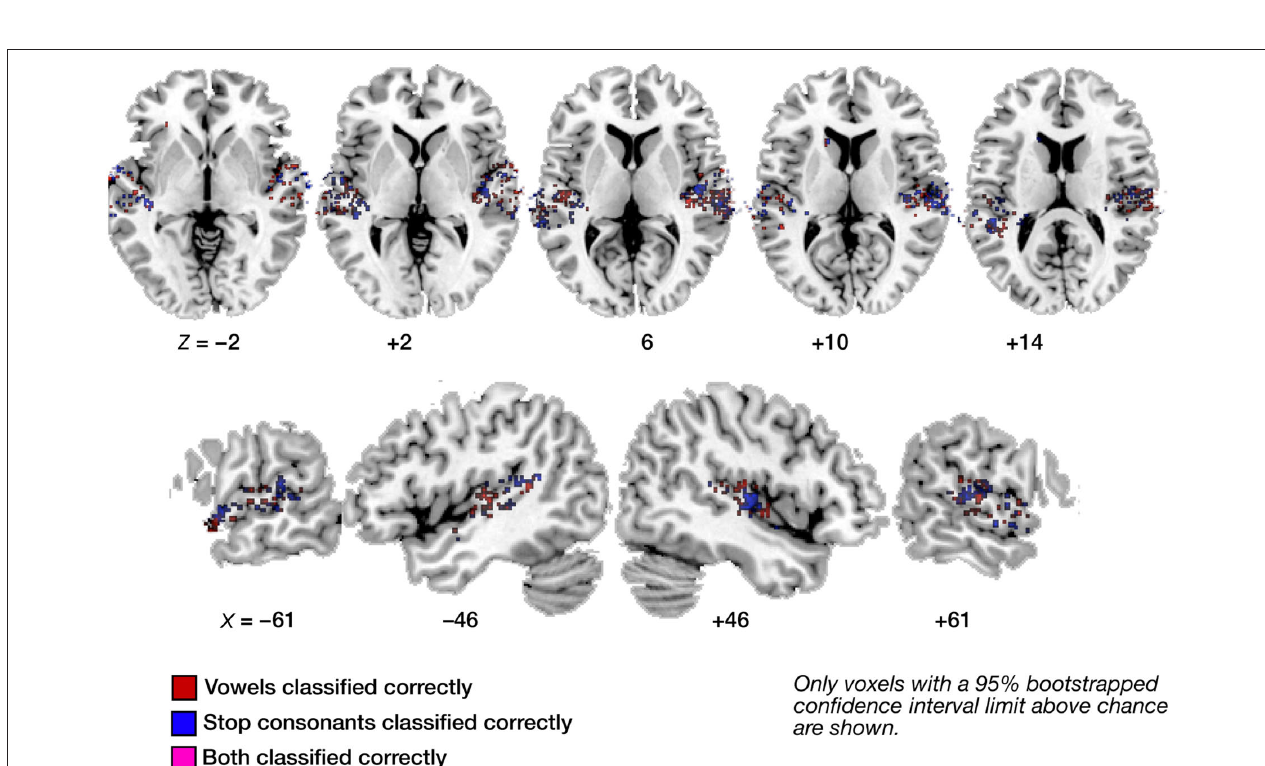
at p < 0.005 at the voxel level and a cluster extent of at least 30 voxels; displayed on an average of all 16 subjects’ T1-weighted images (normalized in MNI space).